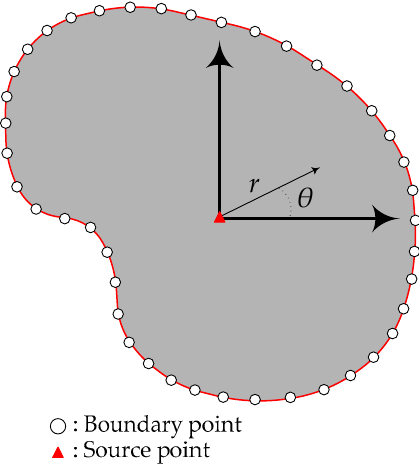
Figure 2. Illustration of the collocation scheme in the CTM.